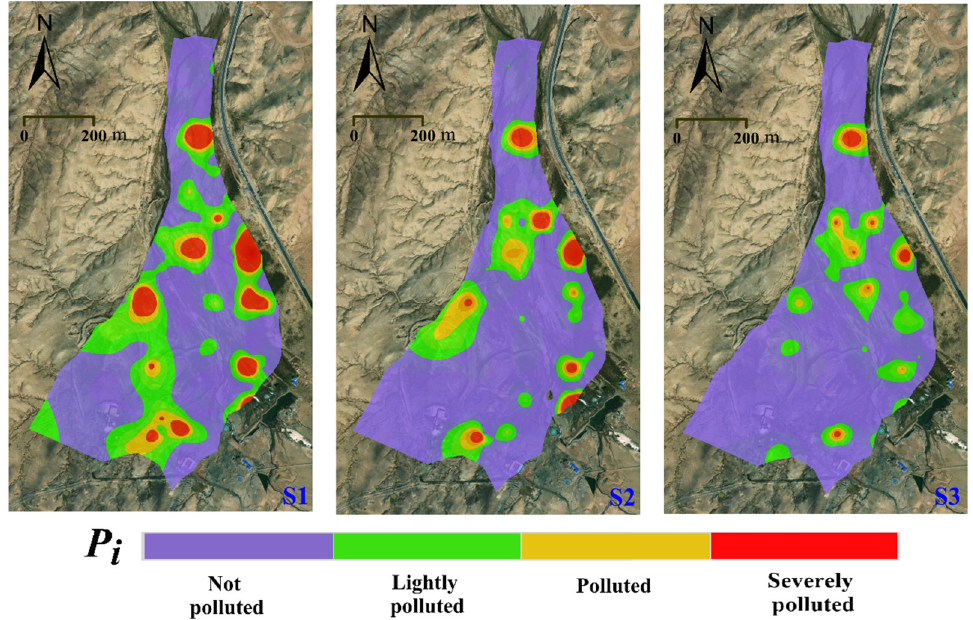
Figure 2. Distribution of P i -values in the study area. S1: 0–10 cm soil layer; S2: 10–30 cm soil layer; S3: 30–50 cm soil layer.